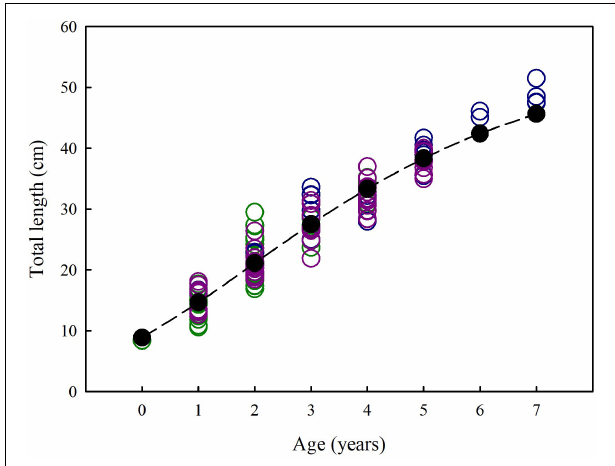
FIGURE 2 | Length-at-age data (empty circles) of C. trigloides from the southwestern Atlantic Ocean fitted to the Gompertz (dashed line, filled black circles) growth models. Different colors indicate different sexes: males (blue), females (pink), and unsexed (green).